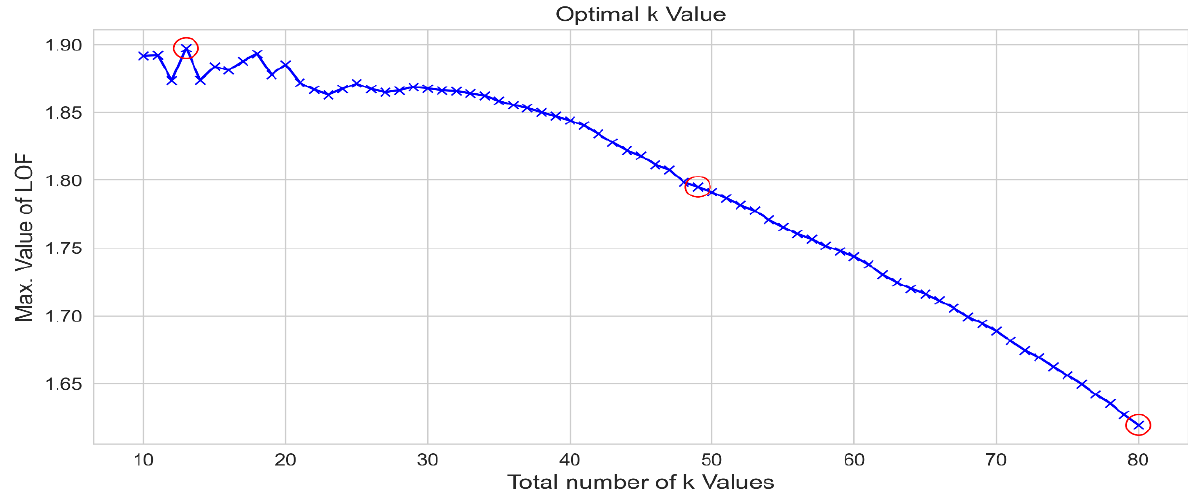
Figure 5. Selection of k values at different instances of LOF score.